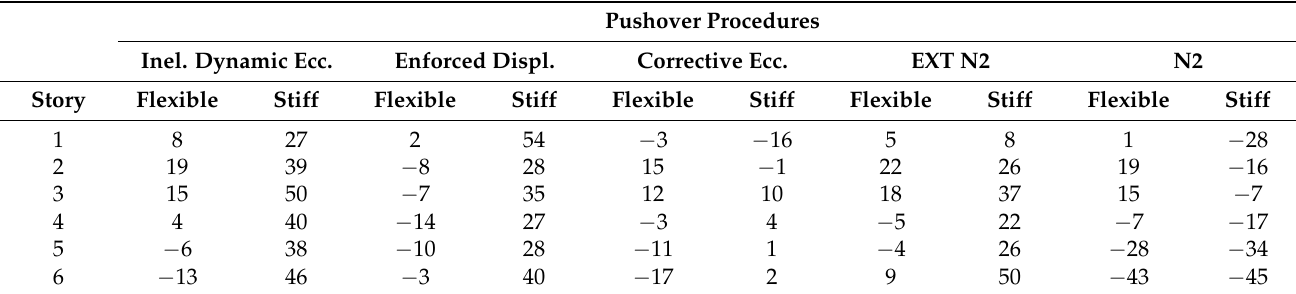
Table 5. Error (%) on the seismic floor angular deformations γ Isec at the stiff and flexible sides along the I sec axis resulted from the examined pushover procedures for case 1 building.